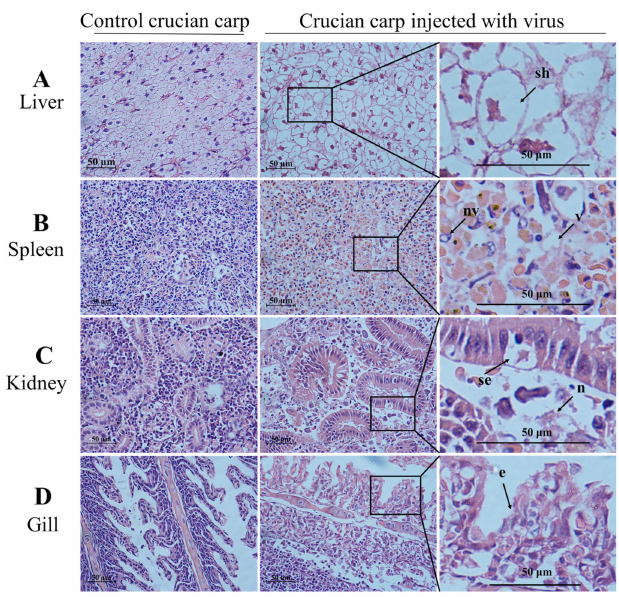
Figure 7. Histological changes in the liver, spleen, kidney, and gill from challenged crucian carp (HE staining). Scale bars = 50 µ m. ( A ) swelling of hepatocytes (sh) and decrease of hepatic sinusoid marked by an arrow; ( B ) nuclear vacuole (nv) and vacuolation (v) in spleen; ( C ) the arrow shows the swelling of renal tubular epithelial cell (se) and necrosis (n); ( D ) exfoliation of epithelial cells (e) marked by an